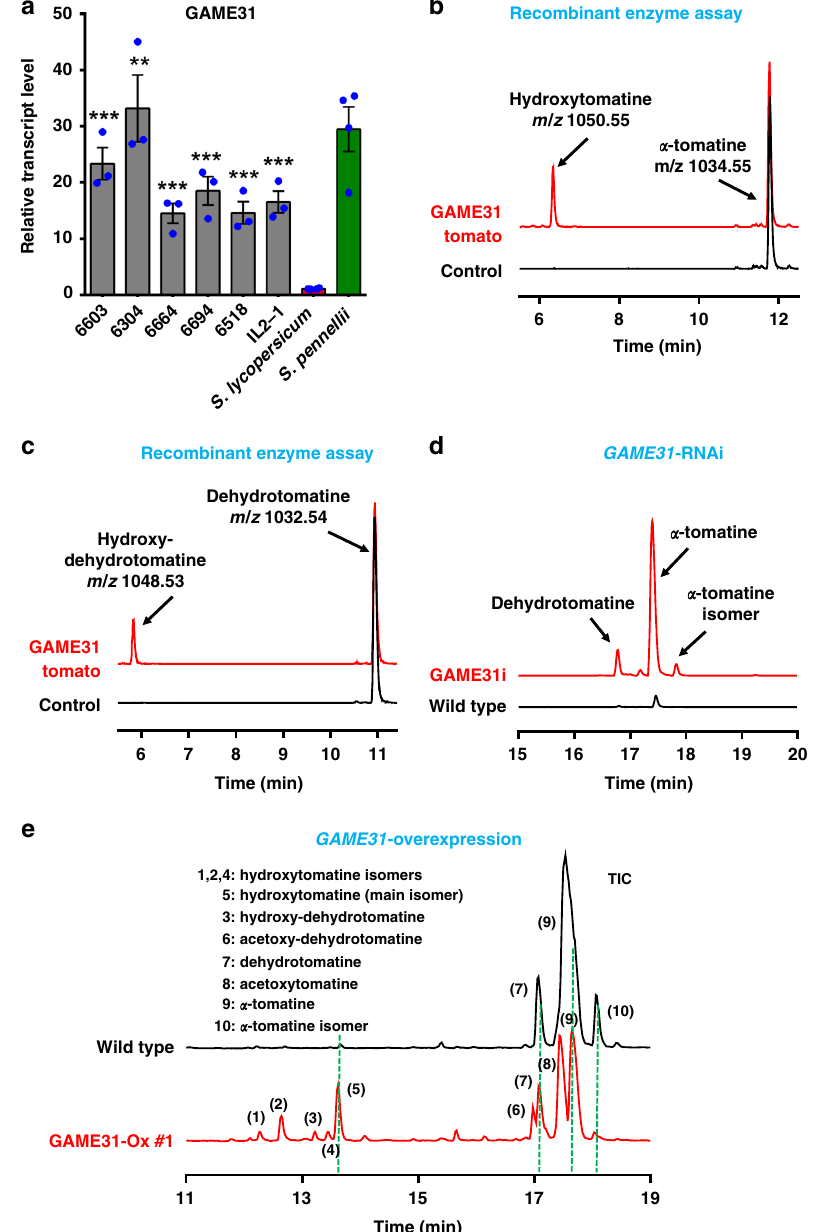
Fig. 4 GAME31 catalyzes the hydroxylation of the bitter fl avor α -tomatine in tomato fruit. a GAME31 expression levels in leaves of selected BILs, IL2-1 line, and parents [ S. lycopersicum ( cv . M82) and S. pennellii ] as determined by quantitative real-time PCR assay. The values indicate means of three biological replicates± standard error mean ( n = 3). Asterisks indicate a signi fi cant difference from S. lycopersicum samples calculated by Student ’ s t test (* P value < 0.05; ** P value < 0.01; *** P value < 0.001). b , c Hydroxylation of α -tomatine ( b ) and dehydrotomatine ( c ) by the recombinant tomato GAME31 enzyme produced in E. coli cells (marked in red). Extracted ion chromatograms were obtained by LC-MS analysis (short 17-min run). The control reaction (shown in black) was performed with the respective substrate using extracts from E. coli cells transformed with an empty pET28 vector. m / z is shown for each substrate and hydroxylated product. Refer to Supplementary Fig. 11 for more information on the GAME31 enzyme assay with α -tomatine as a substrate. Details regarding the identi fi cation of enzyme assay products are provided in Supplementary Figs. 23 and 24. The structure of hydroxytomatine observed in the enzyme assay was elucidated using NMR analysis (refer to Supplementary Table 1). m / z mass to charge, E. coli Escherichia coli . d Red, ripe fruit of GAME31 -silenced plants (RNAi; GAME31i ) accumulated high levels of α -tomatine and dehydrotomatine as compared to wild-type fruit. Extracted ion chromatograms are shown. See Supplementary Fig. 15 for detailed quantitative analysis of SGAs in GAME31 RNAi and GAME31 co-suppression transgenic lines. e GAME31 -overexpressing leaves ( GAME31 -Ox ) accumulate hydroxytomatine isomers and acetoxytomatine, while these SGAs are present in minor quantities in wild-type leaves. Precursor SGAs, α -tomatine and dehydrotomatine, were reduced substantially in GAME31 -Ox lines compared to wild type. Total ion chromatograms are shown. Lines #1 and #2 are two independent GAME31 -Ox transgenic lines (#1 is shown here as a representative